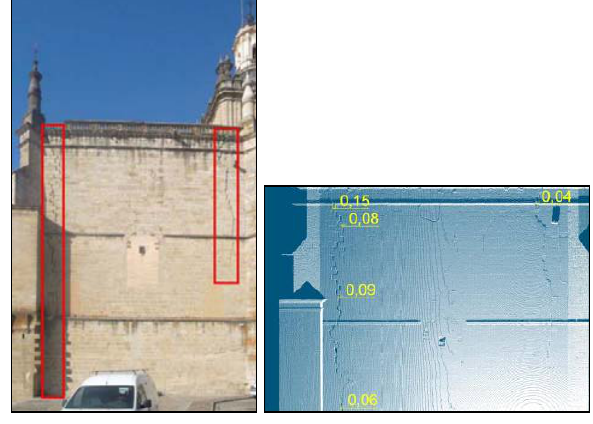
Figure 13. Eastern facade and inventory of cracks (values in meters).